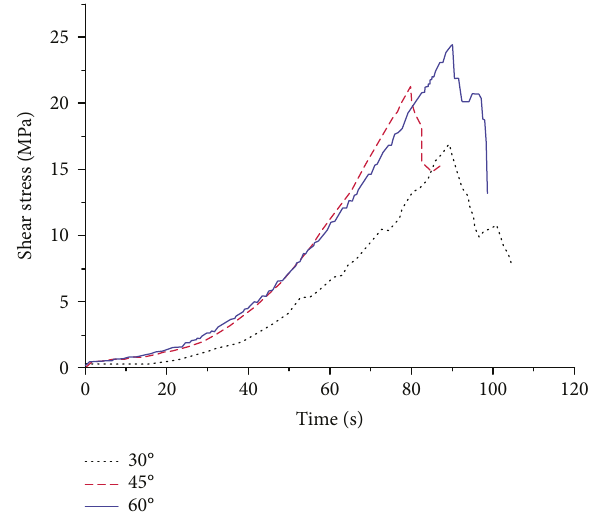
Figure 9: Shear stress-time curves at di ff erent laying angle of the surrounding rock.